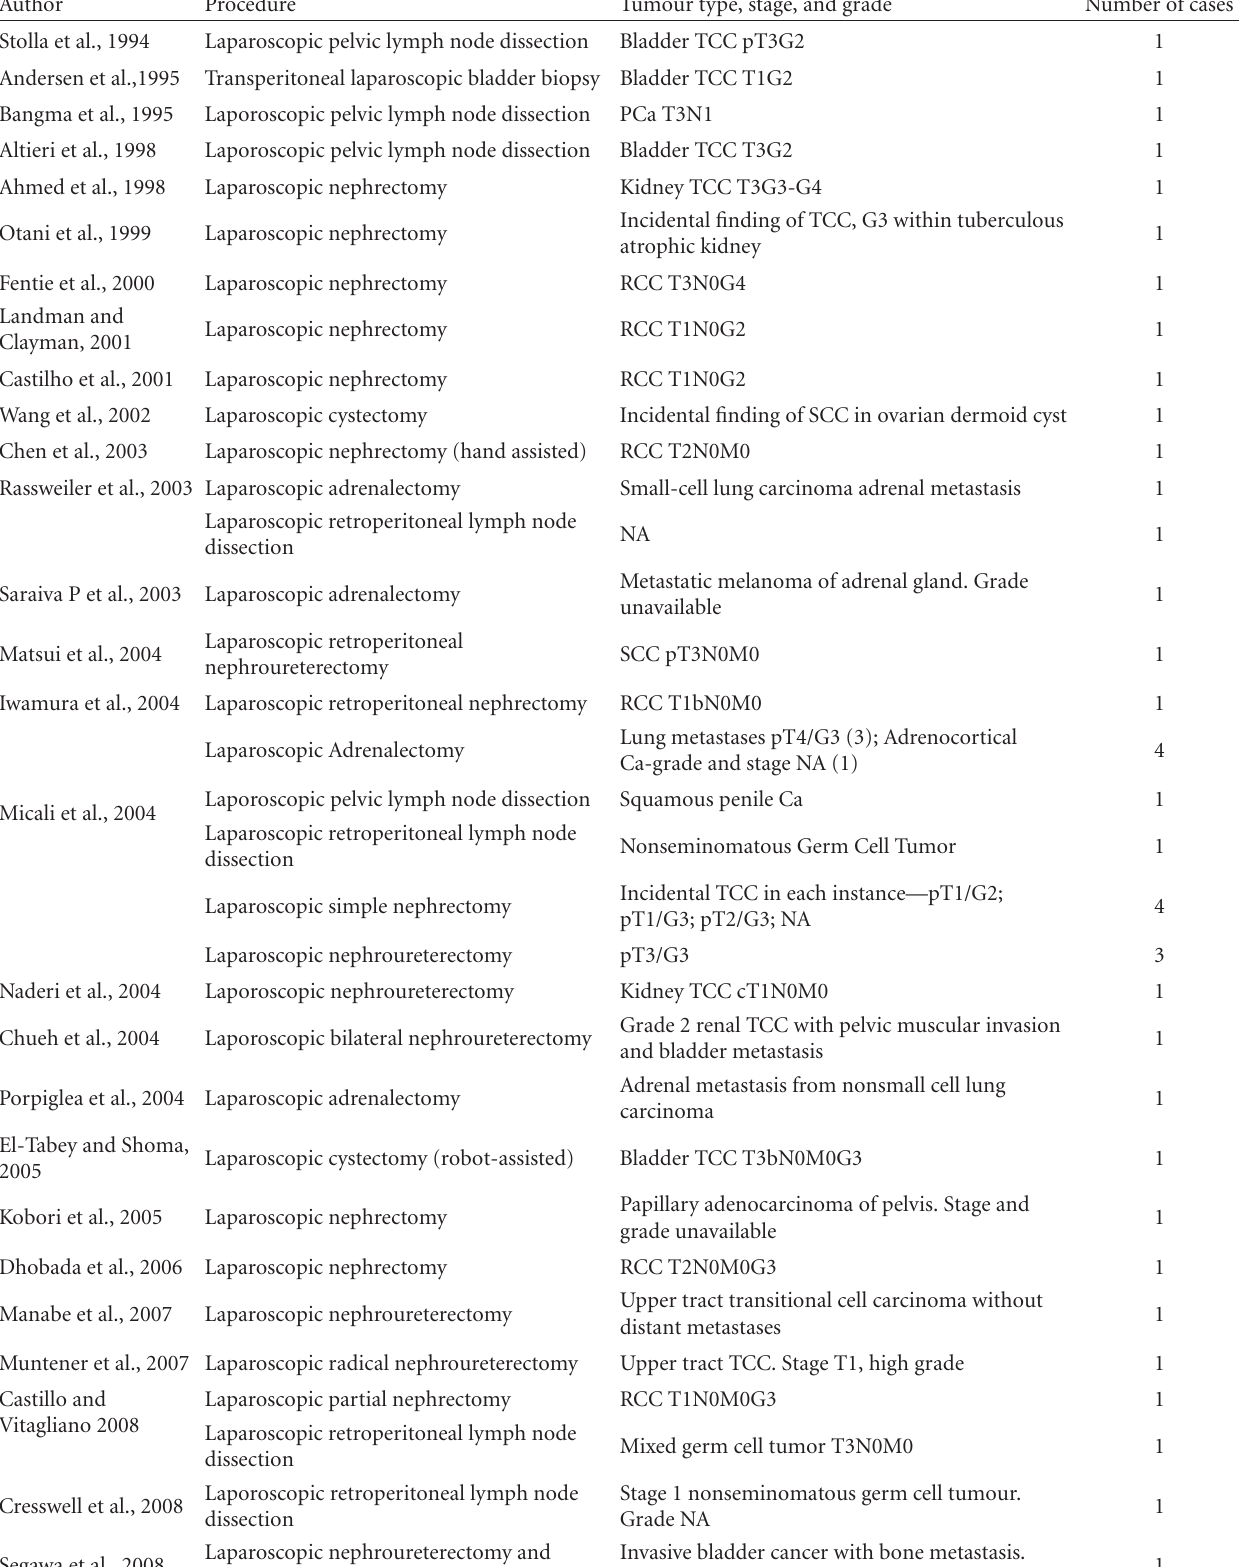
Table 1: The case reports found on